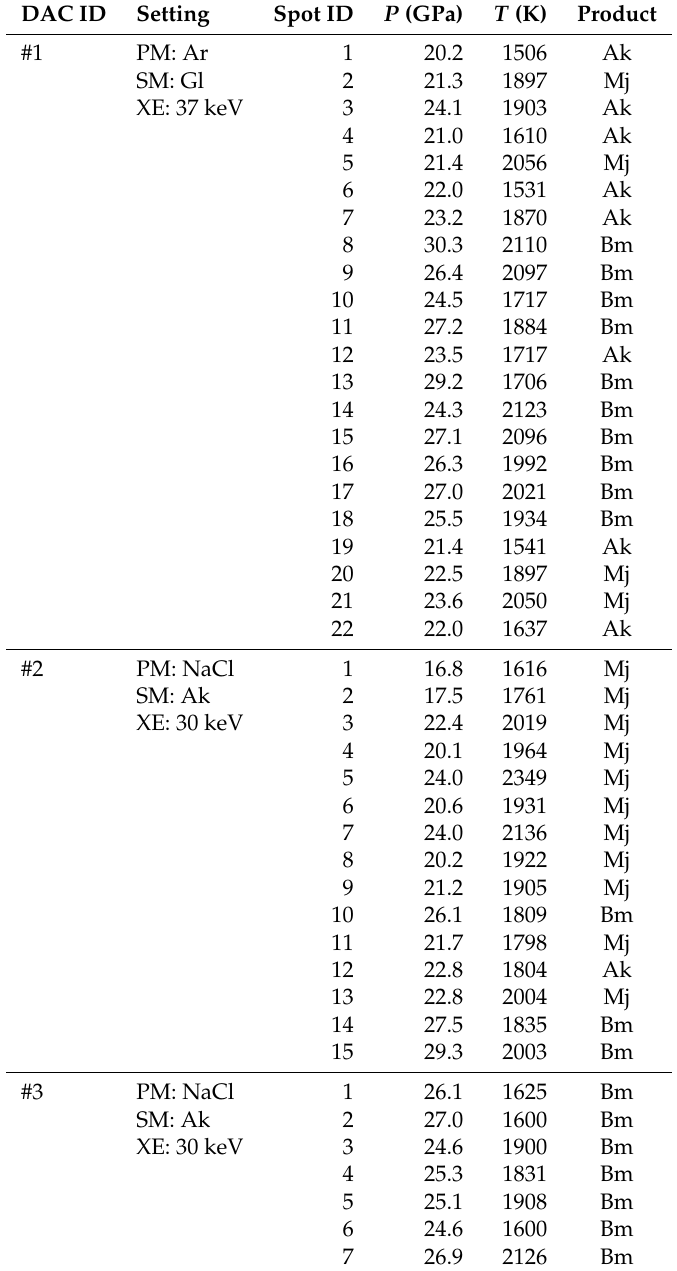
Table 2. Experimental runs in a Laser-Heated Diamond Anvil Cell (LHDAC) in this study. DAC: diamond-anvil cell, PM: pressure medium, SM: starting material, XE: X-ray energy, Gl: MgSiO 3 glass. Other abbreviations are the same as in Table